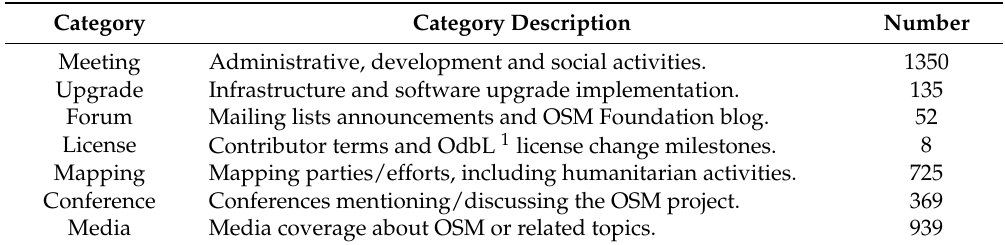
Table 1. Classification of events related to the OSM project